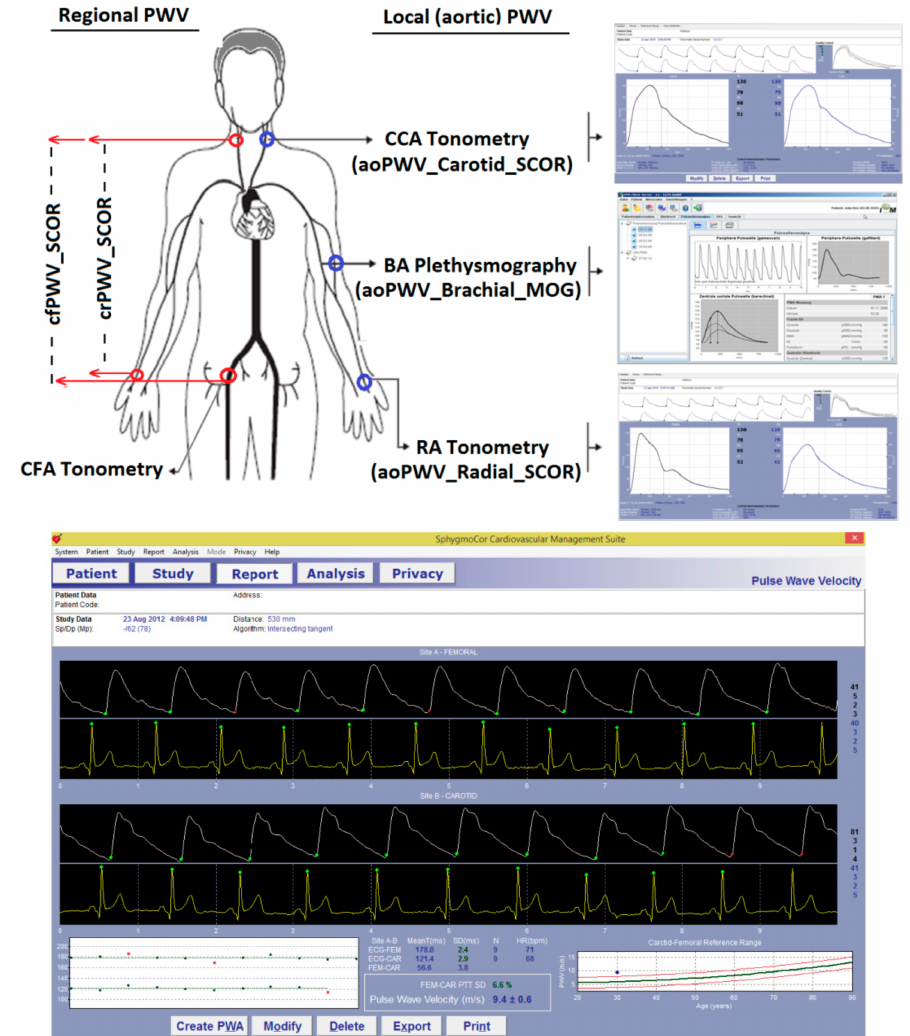
Figure 1. Top : Diagram showing arterial recording sites and pulse waves, measured or obtained to calculate local PWV. Software screens (SCOR and MOG) for carotid and radial applanation tonometry (SCOR) and for brachial oscillom- etry/plethysmography (MOG) records are shown. Bottom : software screen during cfPWV assessment showing the peripheral (femoral) and central (carotid) waves records and the resulting cfPWV (9.4